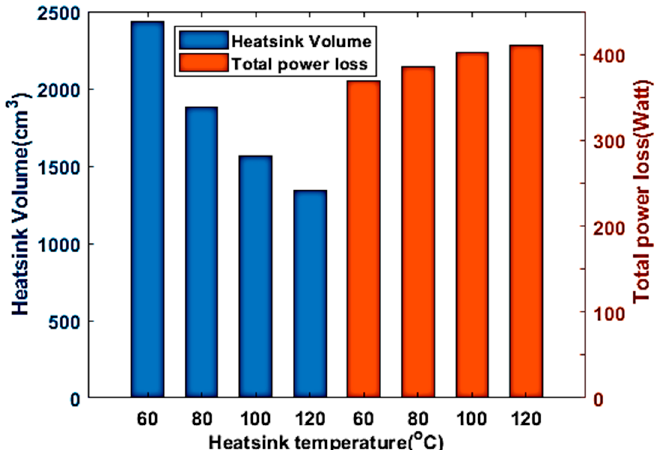
Figure 19. Volume of heatsink and total losses for one leg at different heatsink temperatures.